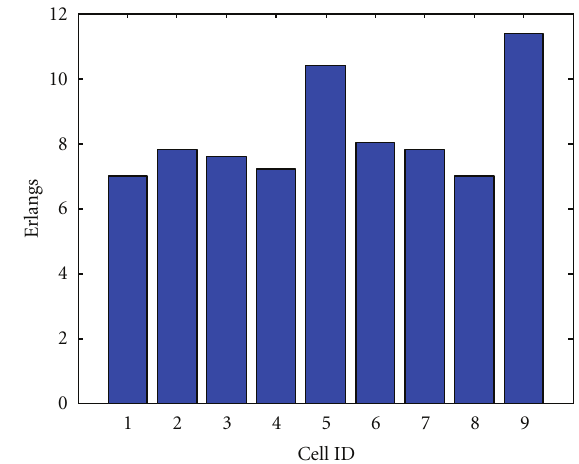
Figure 11: Final load handled by the femtocells (no. of FBSs = 9).